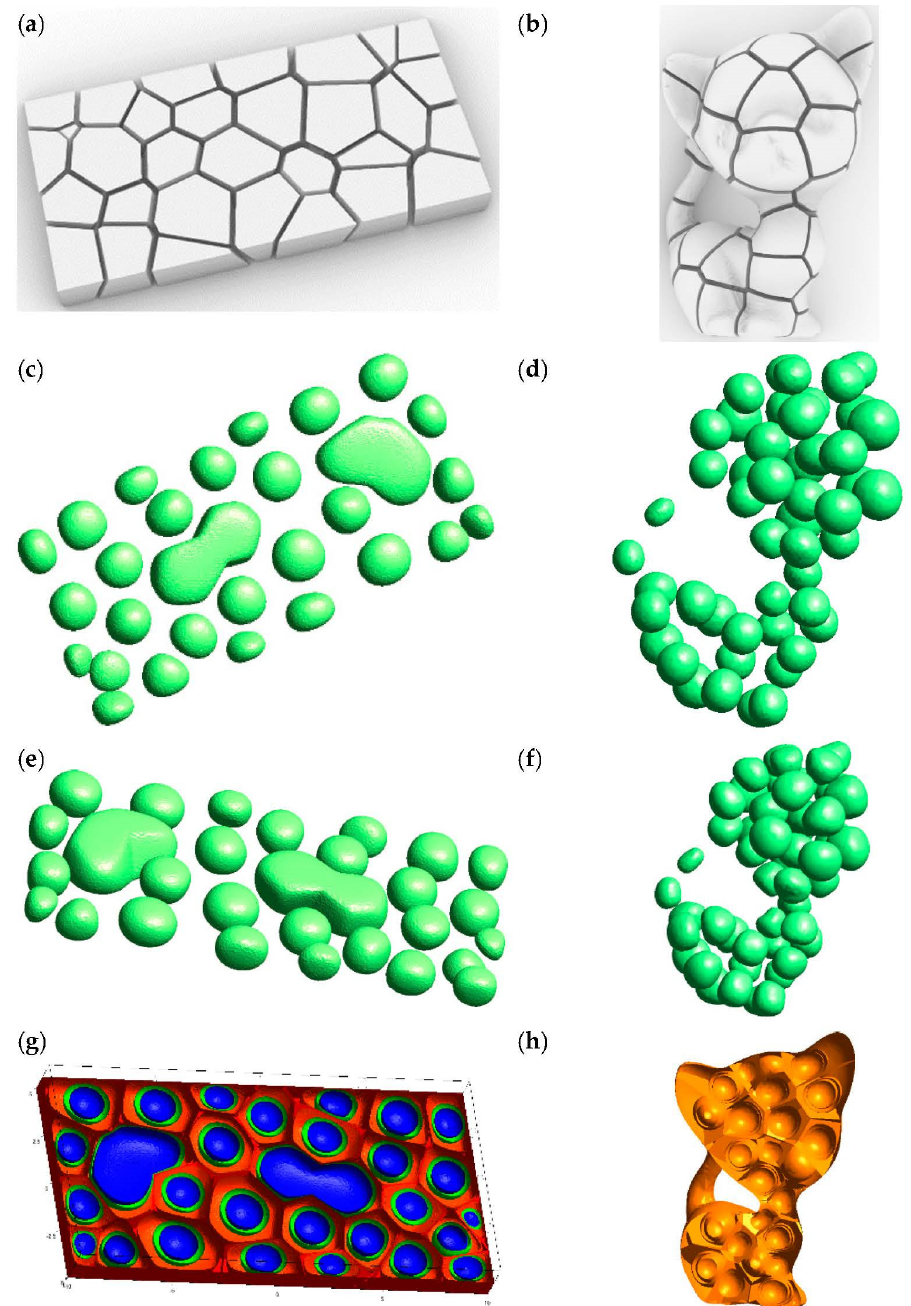
Figure 4. Porous structures generated from cuboid and kitten surfaces. ( a ) is a tessellated cuboid Voronoi cells; ( b ) a tessellated cat Voronoi cells; ( c ) is generated pores from ( a ) with 98 isothermals; ( d ) is generated pores from ( b ) with 98 isothermals; ( e ) is generated pores from ( a ) with 99 isother- mals; ( f ) is generated pores from ( b ) with 99 isothermals; ( g ) are resulting porous structures for ( a ); ( h ) are resulting porous structures for ( b ).